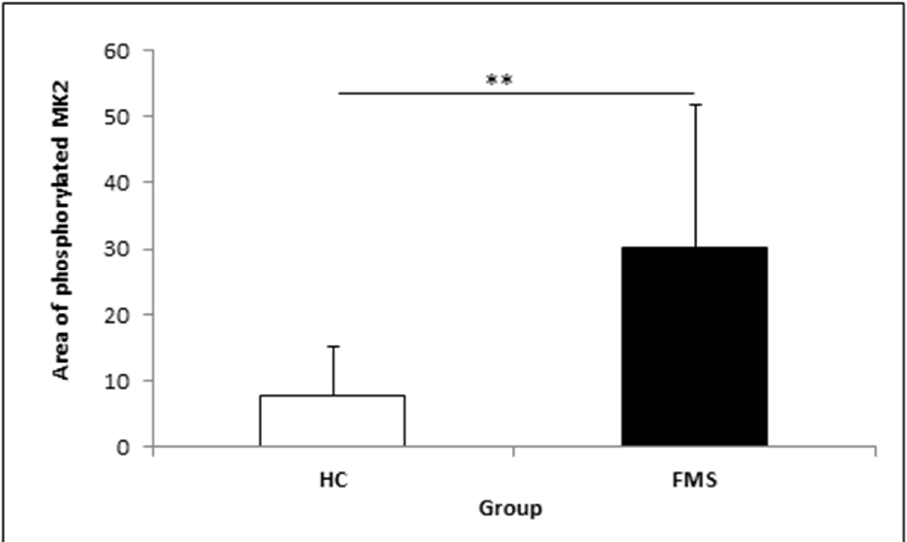
Figure 3. Area of phosphorylated MK2 in peripheral blood monocytes of HCs and FMS patients. (** Student’s t -test: p < 0.001).